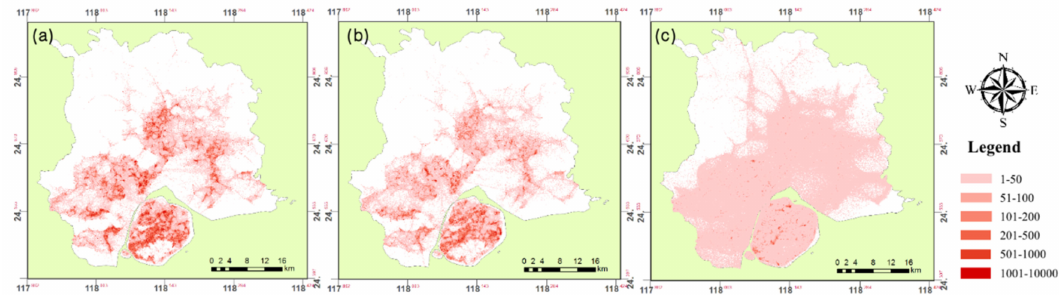
Figure 3. Mobile data of Xiamen: ( a ) resident data; ( b ) working data; and ( c ) visit data.